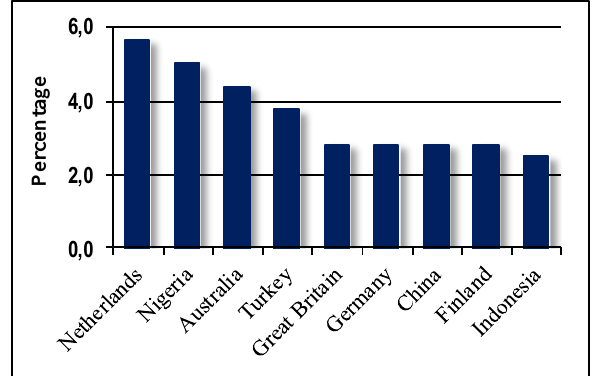
Figure 5. Countries making major contribution in implementation and research related to Cadastre: reforms, systems, innovation, administration, 3D and 4D cadastre,